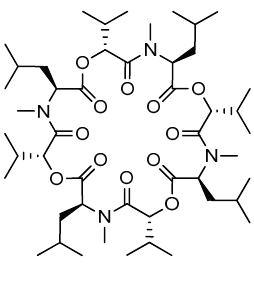
Figure 23. Structure of bassianolide ( 222